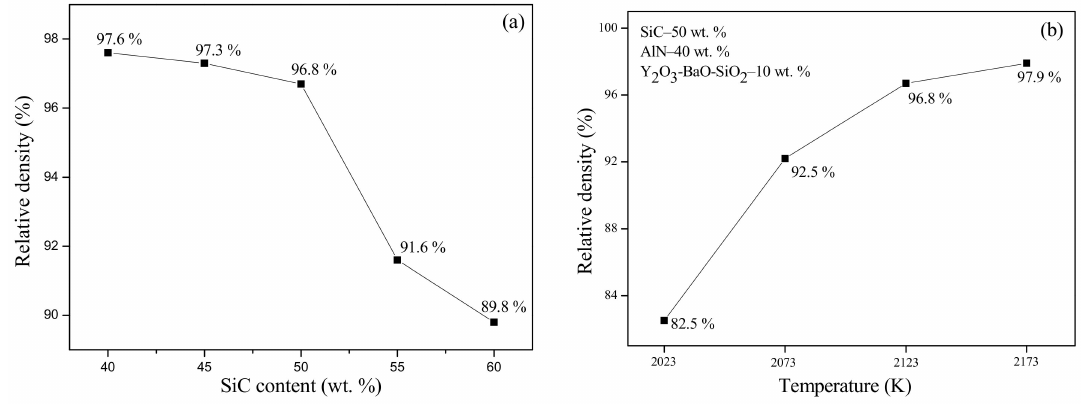
Figure 2. Relative density of the SiC-AlN ceramics. ( a ) Different SiC contents; ( b ) different sintering